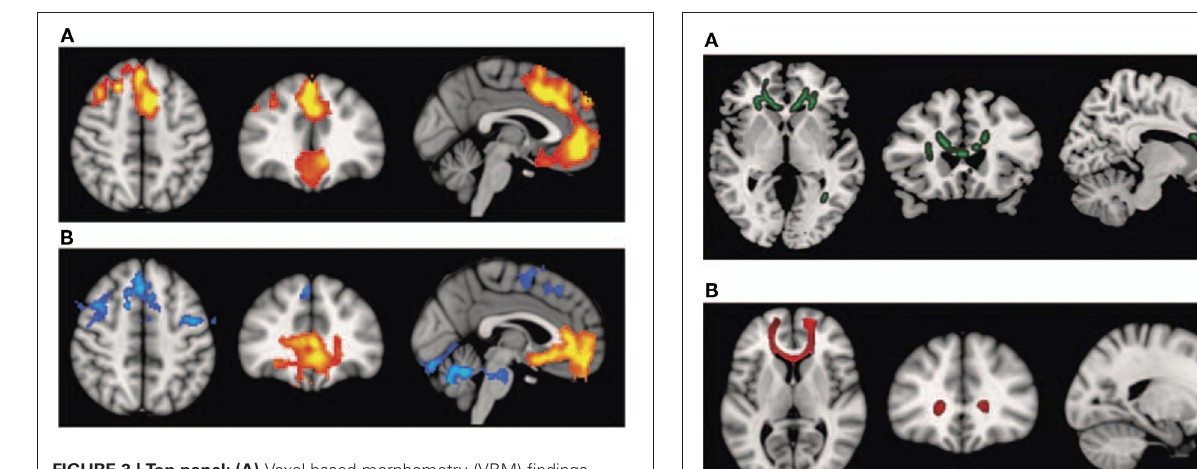
FIGURE 3 | Top panel: (A) Voxel-based morphometry (VBM) findings. Regions showing significant volume reduction thresholded at p = 0 . 01 in the schizophrenic patients are shown in orange. Bottom panel: (B) functional magnetic resonance imaging (fMRI) findings. Regions are shown where there were significant differences between patients and controls during performance of the n-back task (2-back versus baseline comparison), thesholded at P = 0 . 01. Blue indicates hypoactivation, that is, areas where controls activated significantly more than patients. Orange indicates areas where the schizophrenic patients showed failure to deactivate in comparison to controls. The right side of the images represents the left side of the brain. Reprinted from Pomarol-Clotet et al. (2010). Medial prefrontal cortex pathology in schizophrenia as revealed by convergent findings from multimodal imaging. Mol. Psychiatry 15, 823–830 with permission from Macmillan Publishers Limited.